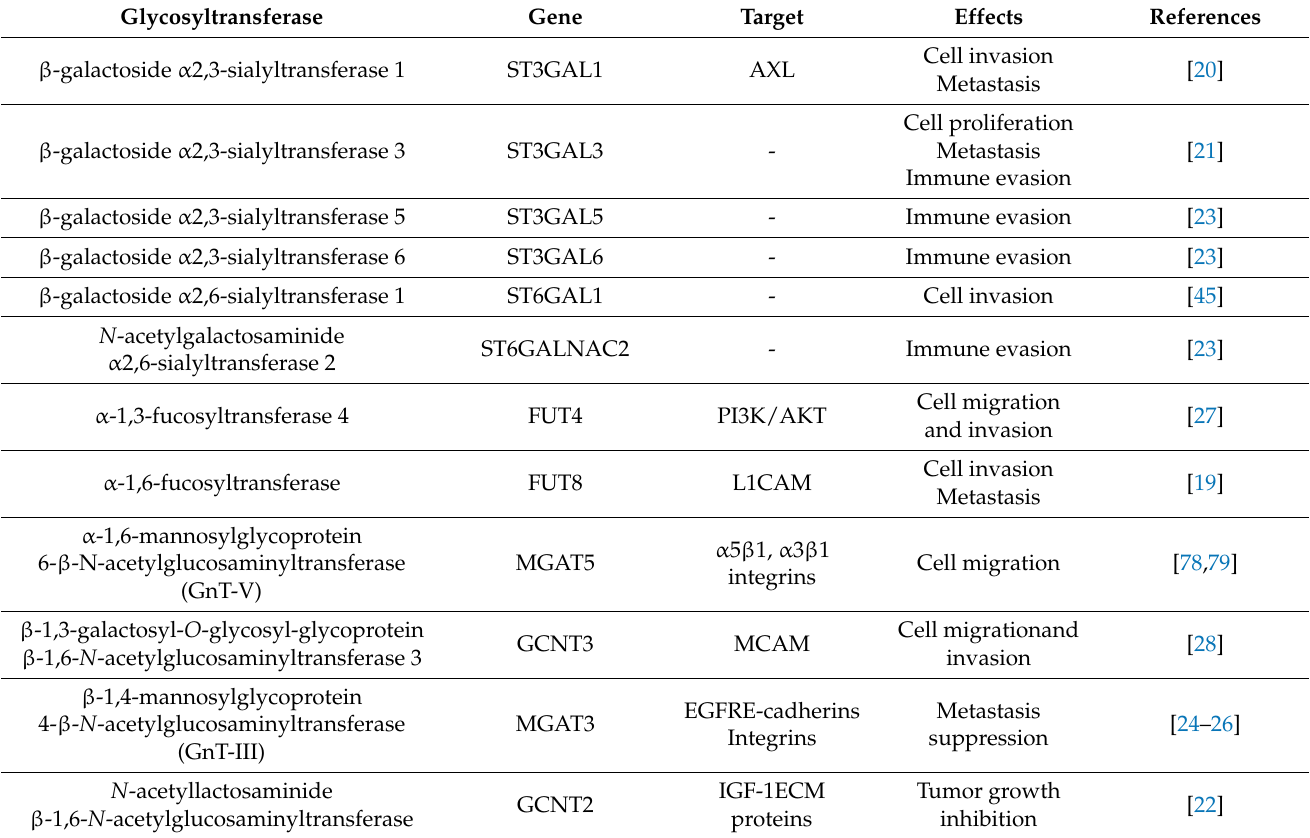
Table 1. The role of glycosyltransferases in